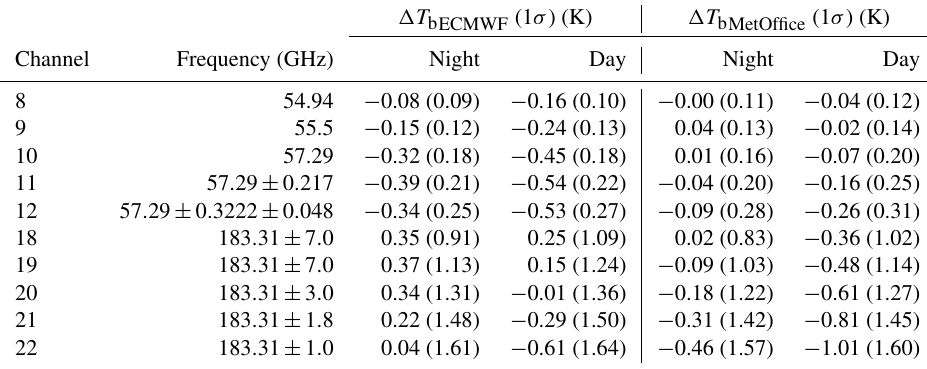
) and 1 σ standard deviation ) and Met Office ( (cid:49)T b MetOffice ECMWF (cid:49)T bECMWF (1 σ )